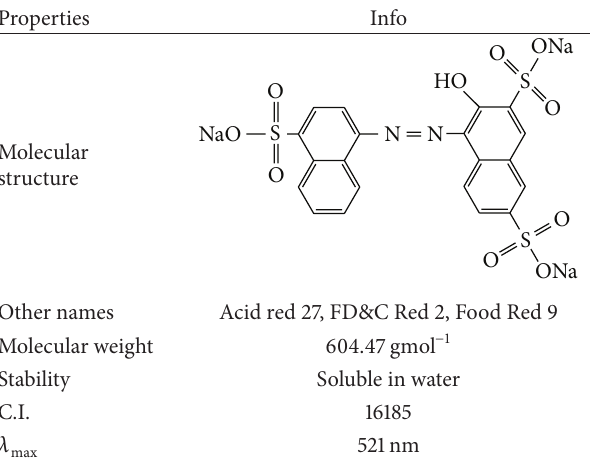
Table 1: Molecular structure and properties of Amaranth